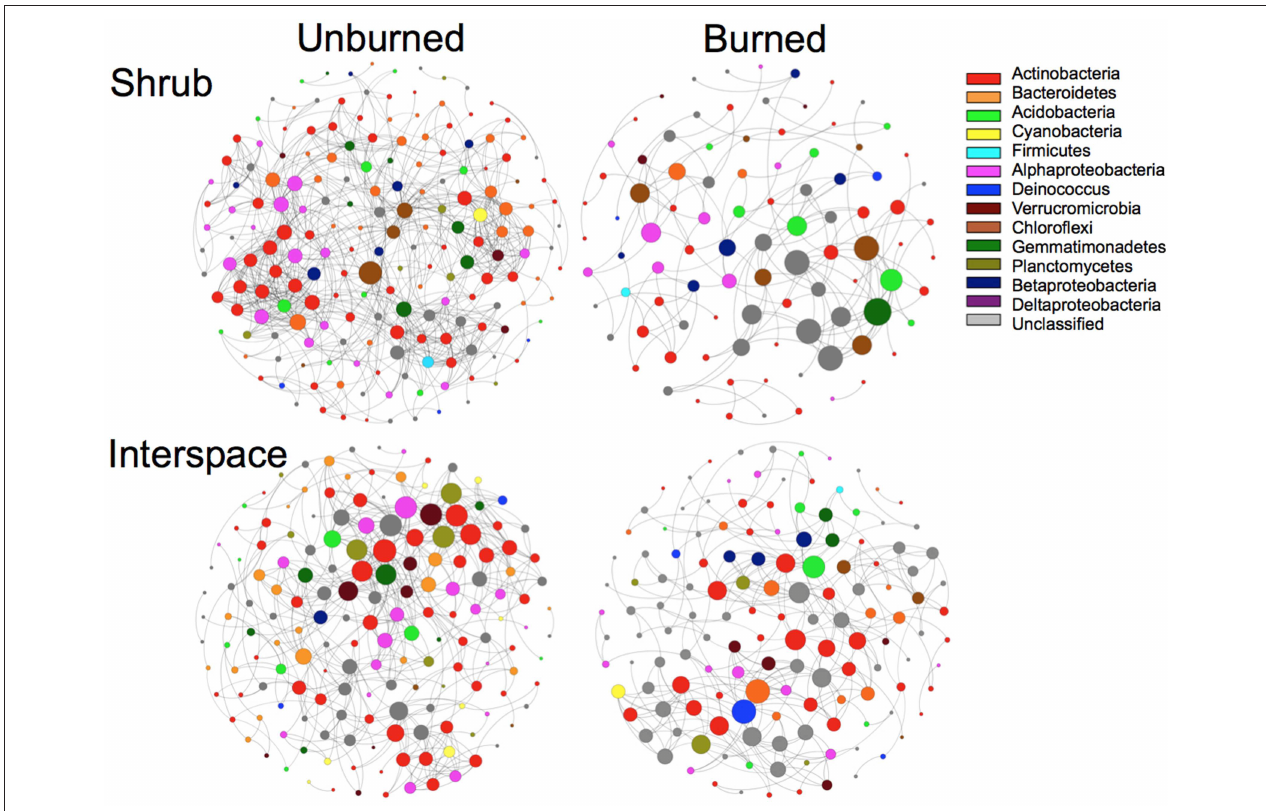
FIGURE 5 | Network co-occurrence models using maximal information coefficient (MIC) analysis of unburned and burned biocrusts after fire. Nodes (circles) in the network models represent OTUs from 16S rRNA gene community libraries (97% similarity cut-off) with edges (connecting lines between nodes) representing significant co-occurrence connections that occur in at least 75% of the samples for a given microsite and have an MIC that is both > 0.7 and statistically significant ( P < 0.01, n = 6). Colors represent different phyla as shown in the figure key. The size of the nodes indicates the number of significant connections between the given node and other taxa.